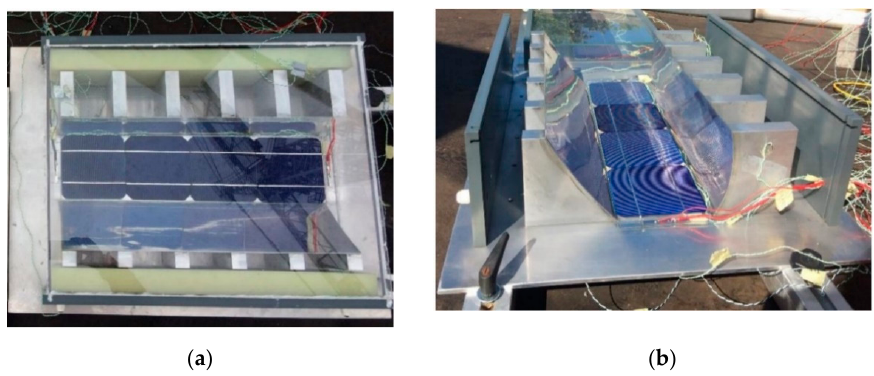
Figure 1. Compound Parabolic Concentrator (CPC) prototypes installation: ( a ) covered CPC system; ( b ) uncovered CPC